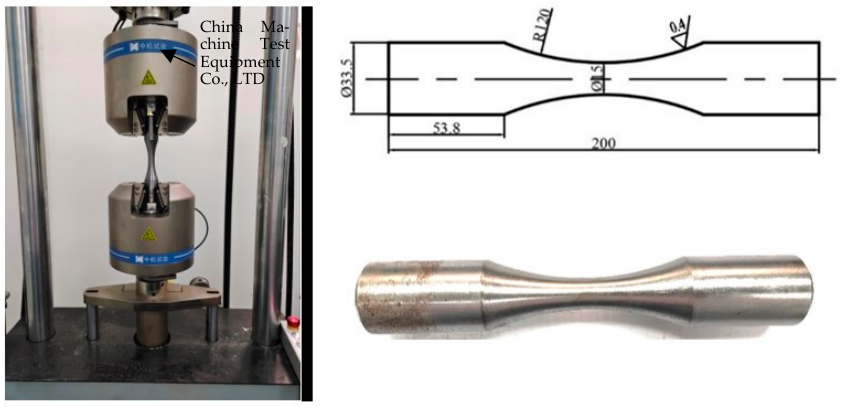
Figure 6. The 20MnTiB fatigue specimen and test equipment (mm). Table 3. Experimental results by tensile and compression